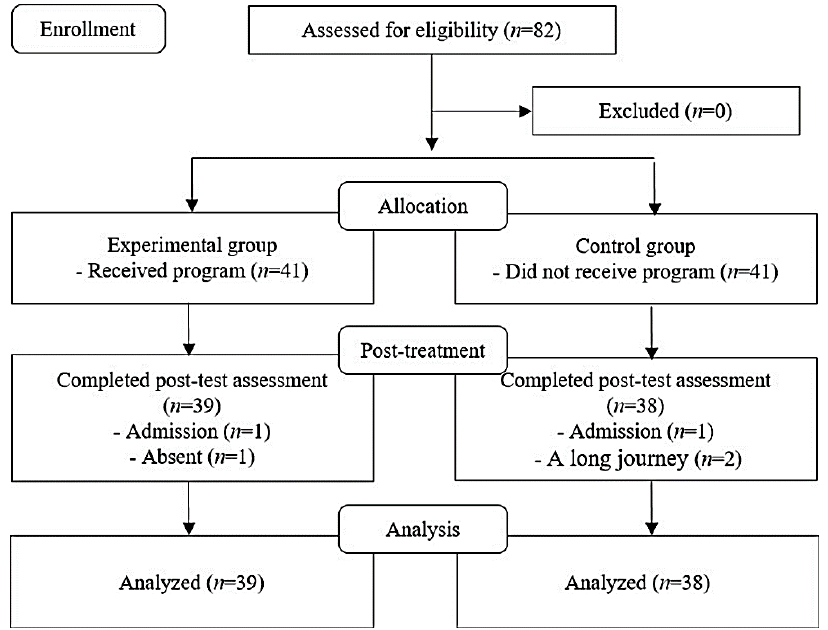
Figure 1. Flow diagram in this study.